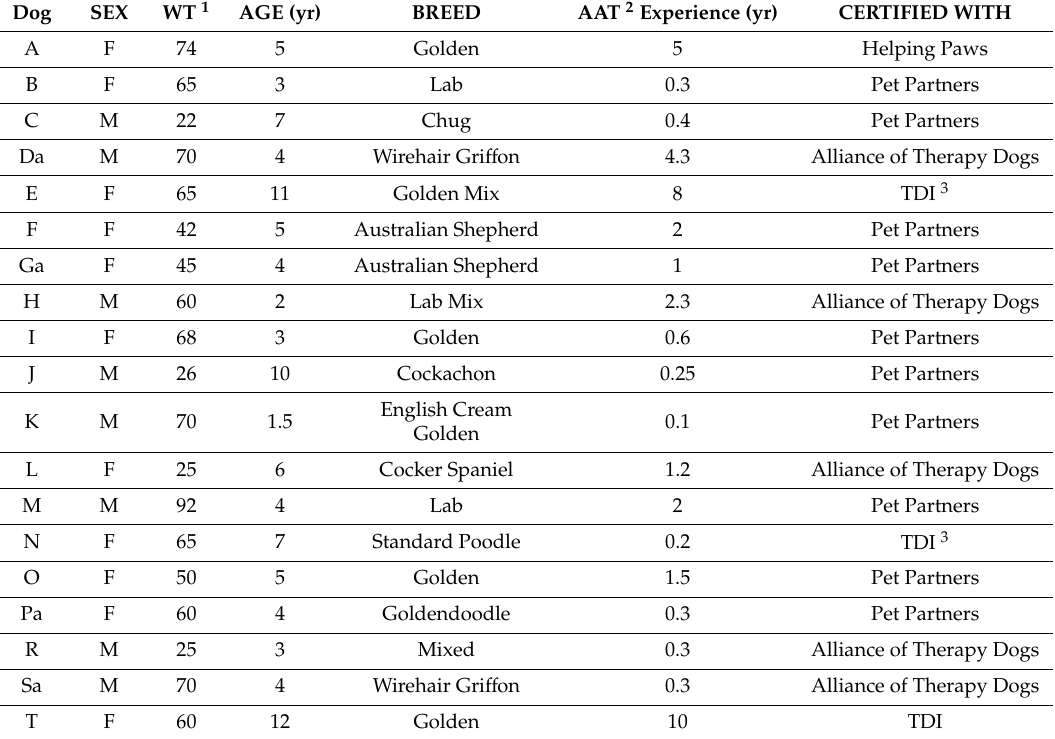
Table 1. Description of the dogs involved in the